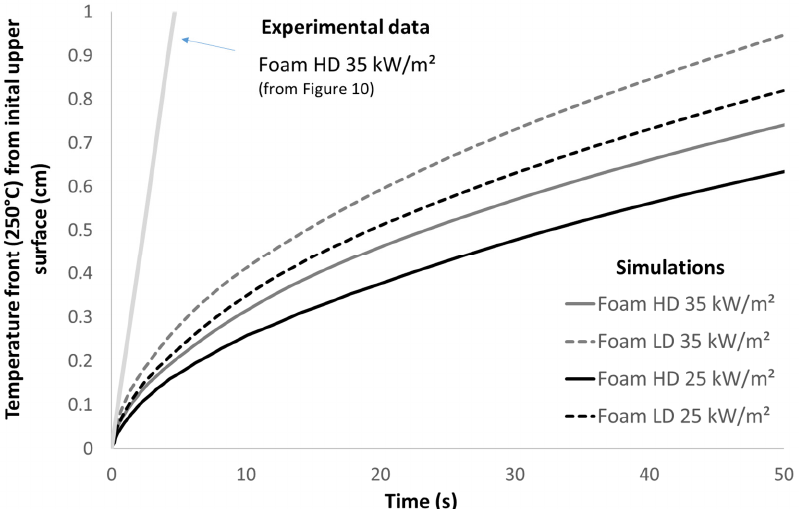
Figure 13. Evolution of the temperature front versus time for different simulations and experimental data corresponding to the HD foam at 35 kW/m 2 (Figure 10).